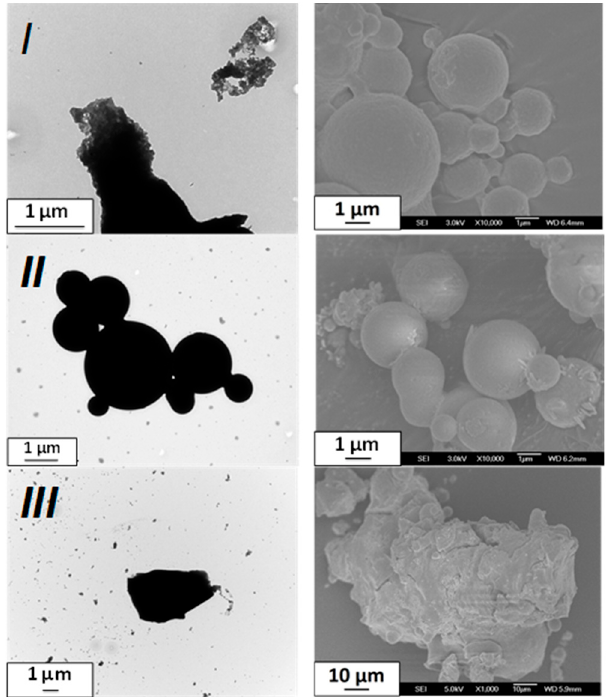
Figure 2. TEM and SEM images of the particles obtained from spray-drying for the selected batches I , II , and III for [Fe(NH 2 trz) 3 ]Br 2 ·nH 2 O.